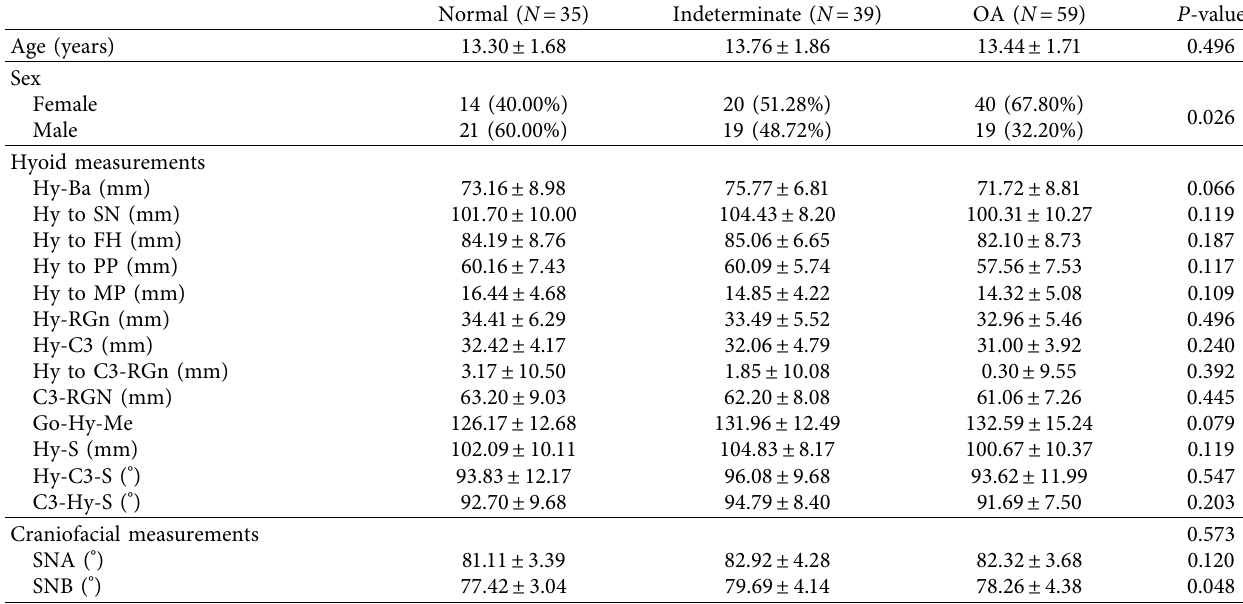
Table 7: Differences in hyoid and craniofacial measurements among the three groups in subjects aged < 18